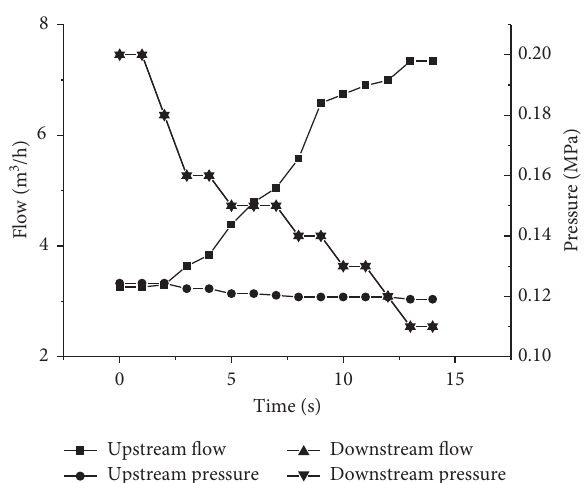
Figure 6: Pressure and flow data collection at 0.2 MPa leakage.